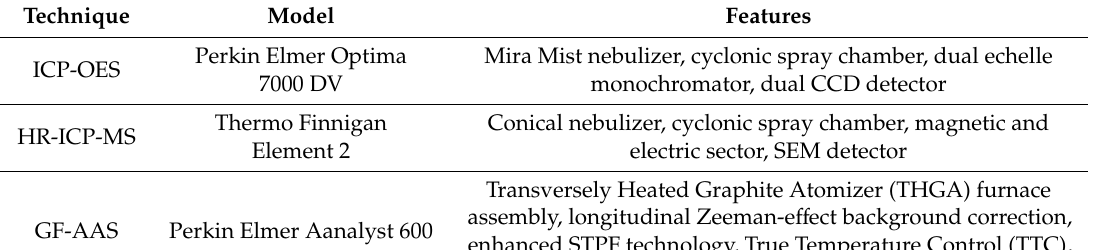
Table 1. Models and technical specification of instrumental techniques used for the analyses.